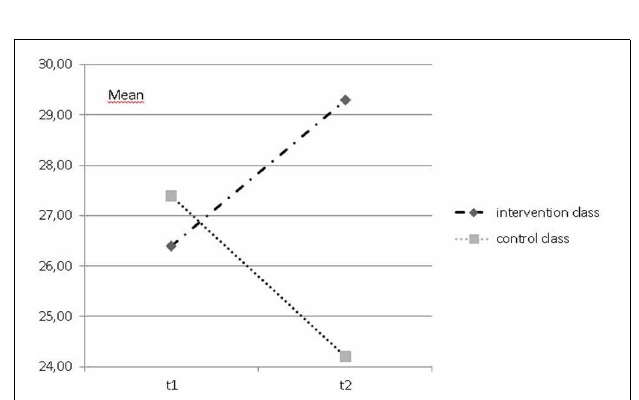
FIGURE 1 | Mean of FEESS-scale positive attitude toward school at t1 and t2 for intervention and control class.